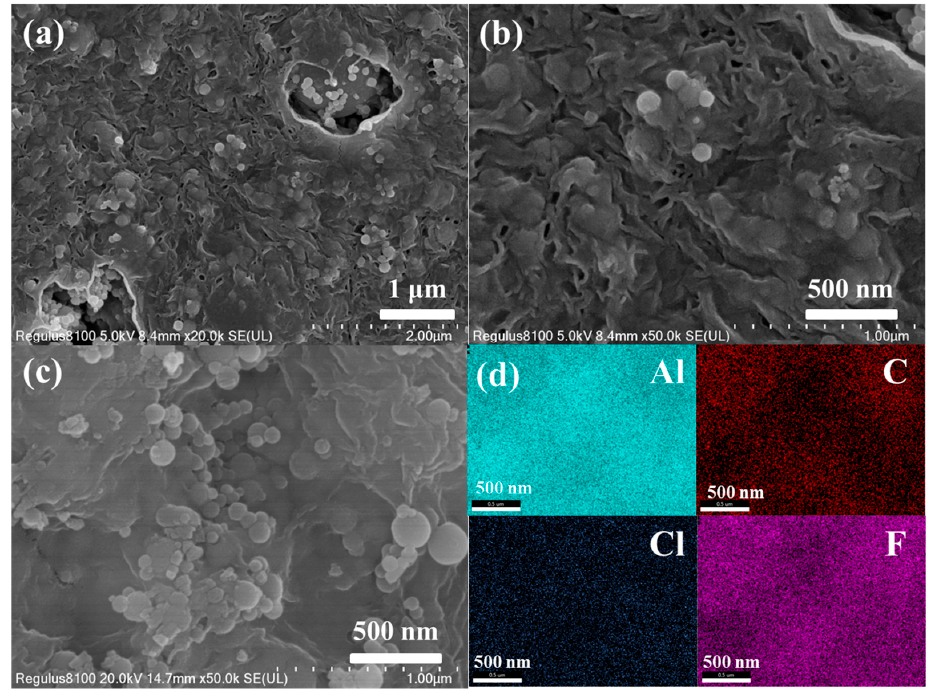
Figure 3. ( a , b ) Top ‐ view SEM images at different magnifications and ( c , d ) elemental mapping im ‐ ages of Al, C, Cl and F species of APK ‐ 3. of Al, C, Cl and F species of